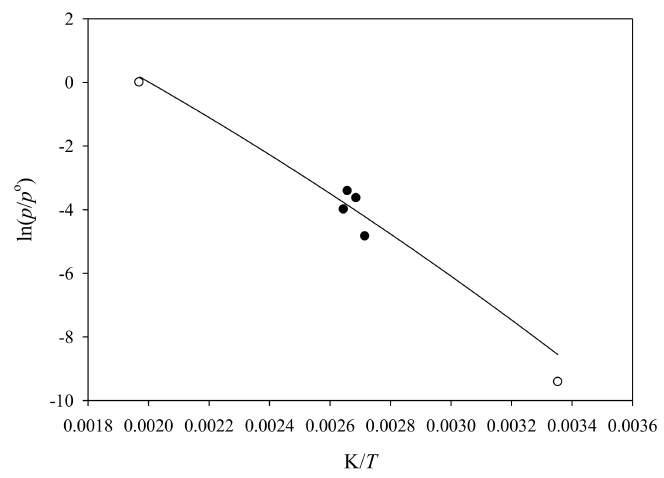
Figure 2. Line: a plot of ln ( p / p o ) vs. K/ T of N-ethylamphetamine from T = (298.15 to 500) K; • : experimental boiling temperatures at reduced pressures (most volatile to least volatile [26–29]; o: estimated values